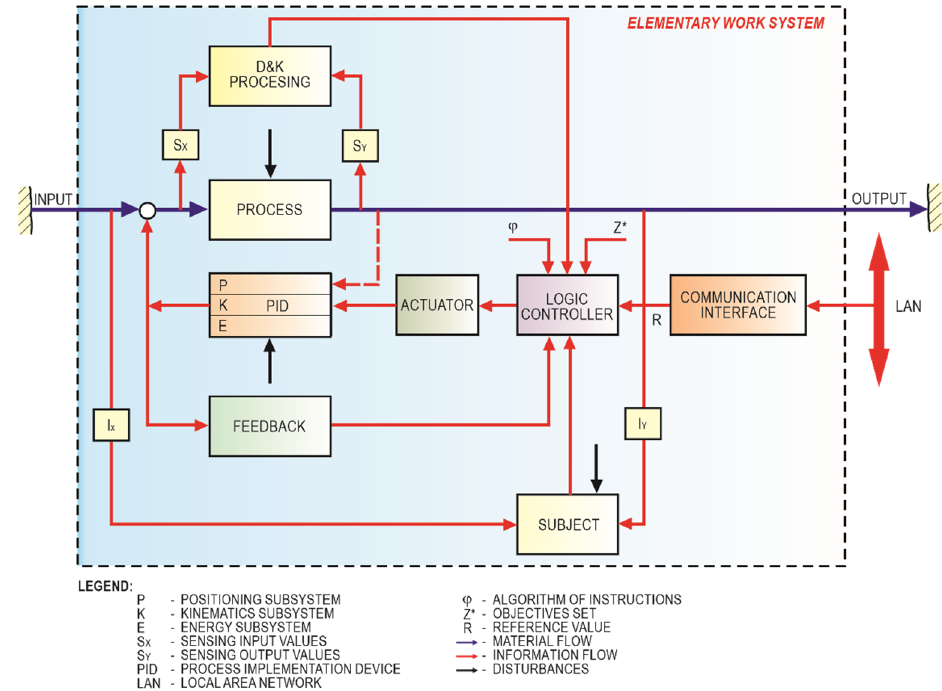
Figure 8. Structure of elementary work systems [32].